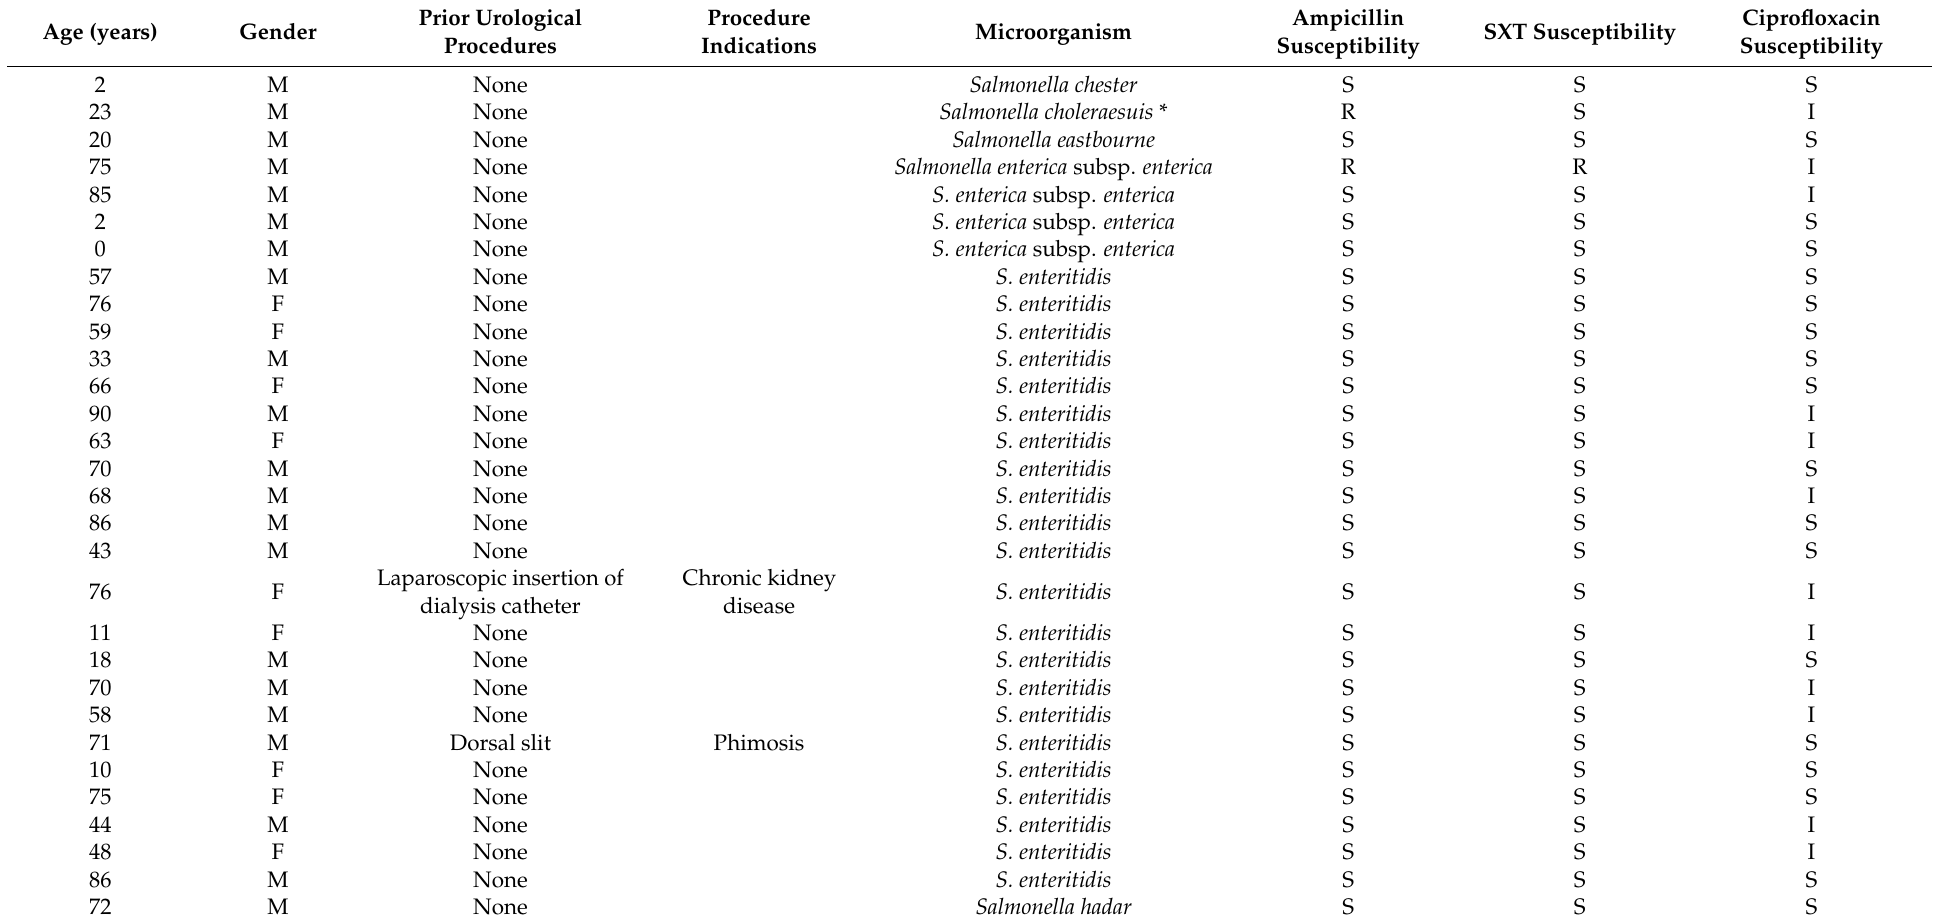
Table 3. Patients identified to have Salmonella bacteremia in 2017–2019, sorted by names of the